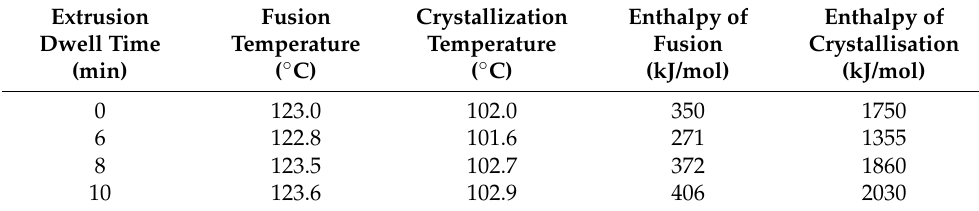
Table 5. Fusion and crystallisation temperatures of LLDPE/MP